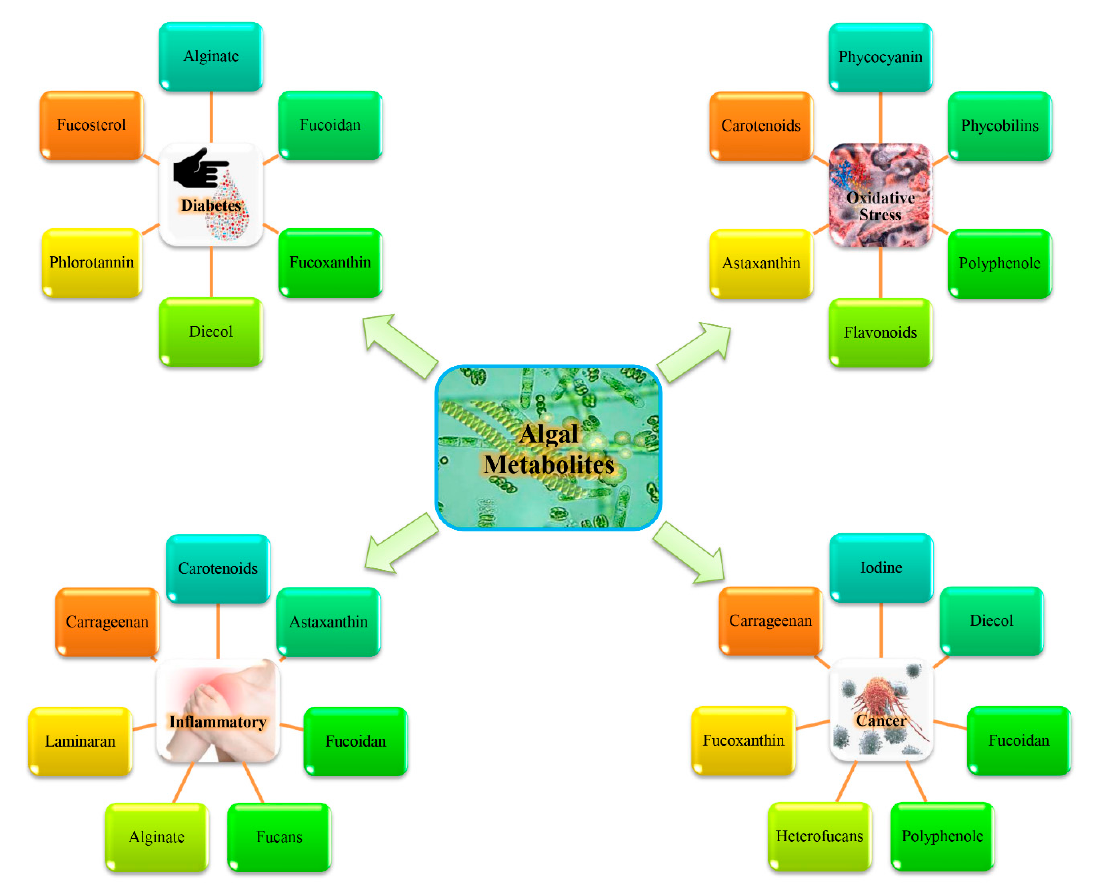
Figure 3. Potential effects of algal metabolites in different human disease.